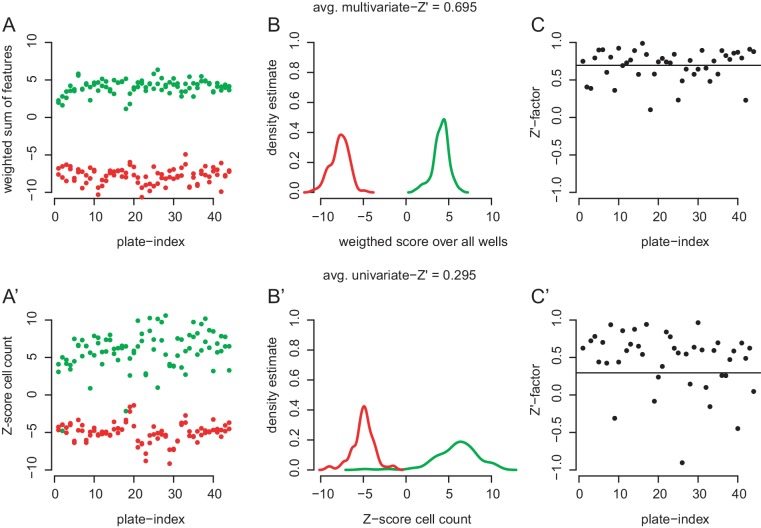
Ability of the cell morphology assay to distinguish phenotypes produced by control dsRNA.(A,A’) Cells were pertubed with dsRNA against RasGAP1 (green) and drk (red) and treated with 0.5% DMSO (#1 dsRNA designs). Each plate contained two wells of each control. (A) Weighted feature sums were summarized by multiplying each feature score with the feature’s scaling in an linear discriminant analysis (lda) between positive and negative controls. The lda was performed on data from all plates together. The weighted sum of scores is plotted against the plate index. (A’) Data for unscaled cell count only plotted against palte index. (B) Density estimates of the data shown in (A). Note the good separation betwenn positive and negative control phenotypes. (B’) Density estimates of data shown in (A’). Note significant overlap between the two control populations. (C) Multivariate Z’-factors on the basis of 38 selected features (Caicedo et al., 2017). An average Z’-factor of 0.695 marks an almost excellent performance of the multivariate assay to disguish controls in most plates. (C’) When using only one readout such as cell count, the average Z’-factor drops to 0.295.